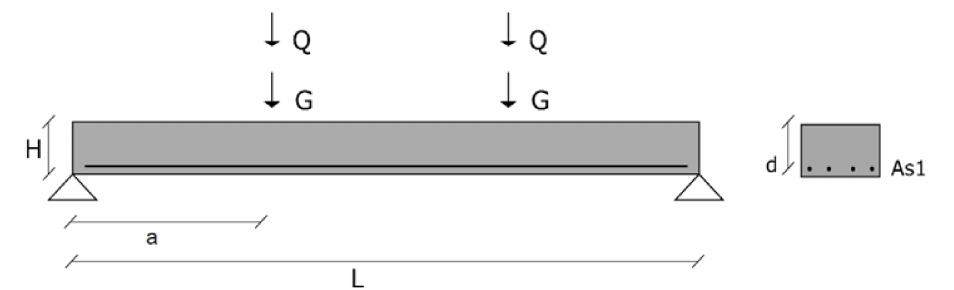
Figure 1. Case of design of the reliability analysis. Slab without shear reinforcement. Table 1. Cases of design for shear design of NAC slabs without shear reinforcement using prEN1992 [32]. Slab